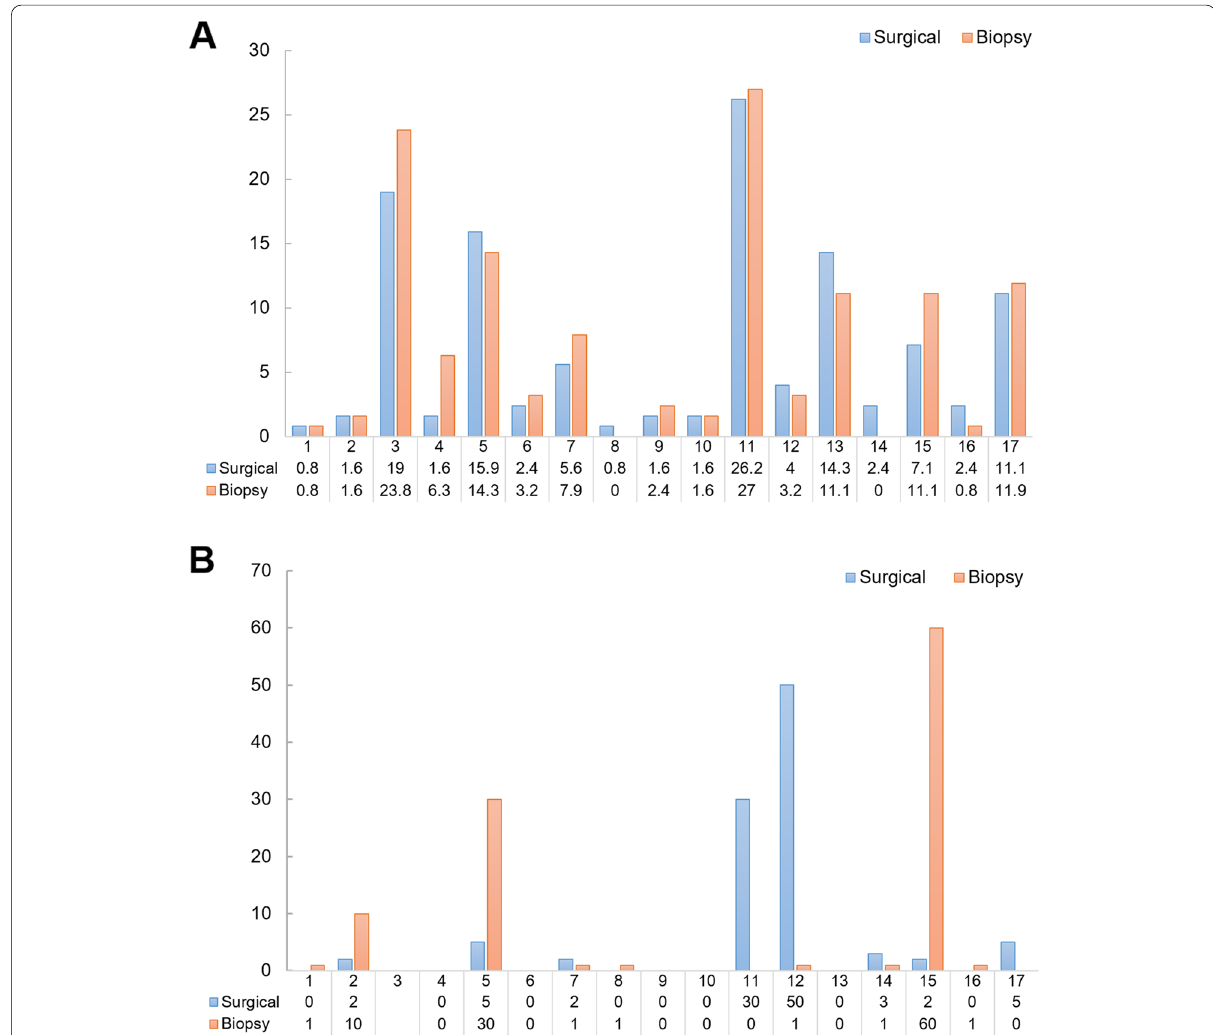
Fig. 4 A Tumor mutational burden (in Mutation#/Mb) of paired specimens; B PD patient 03 did not satisfy the standard of quality control. PD-L1, programmed death ligand 1; TPS, tumor proportion